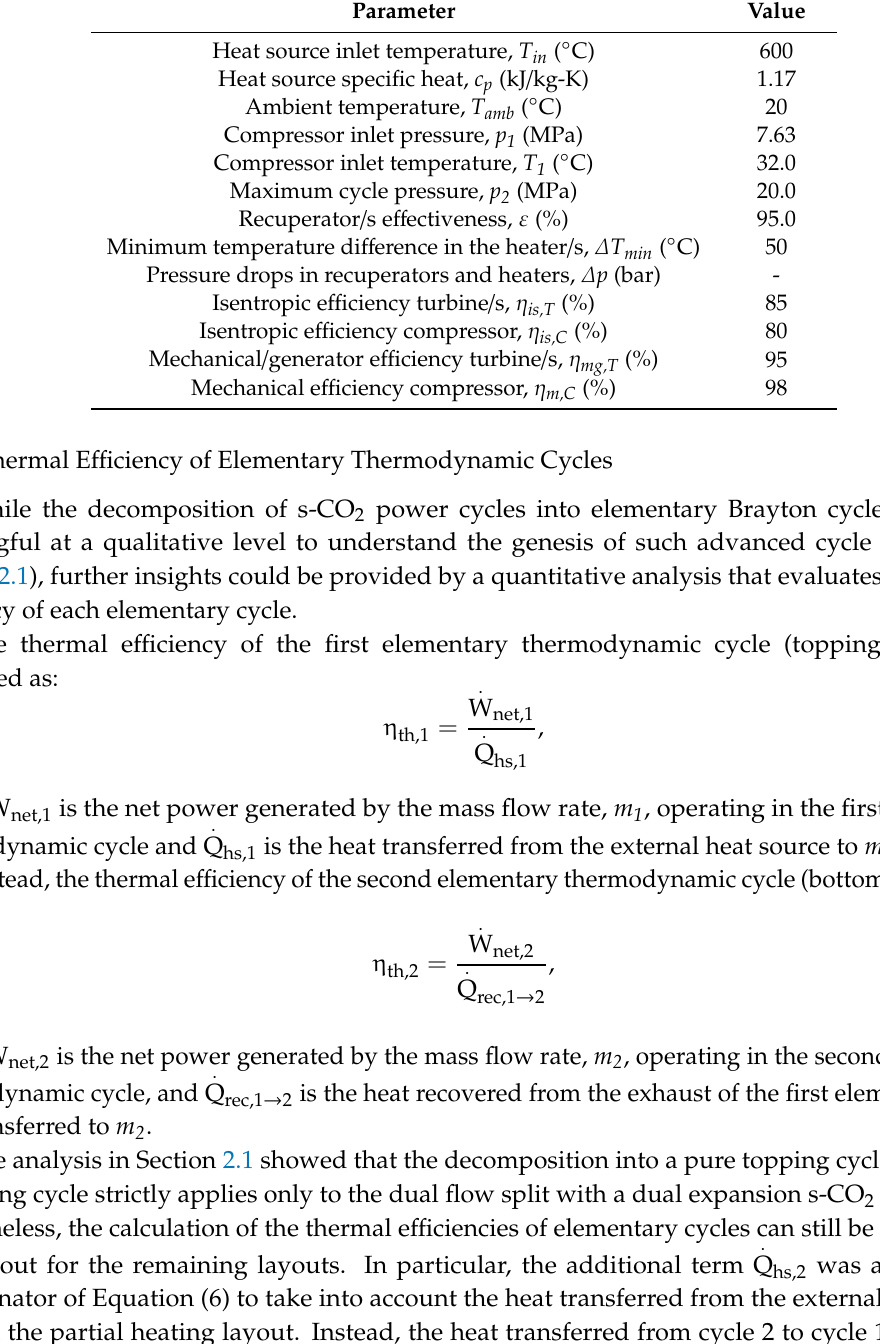
Table 1. Main assumptions in the simulation models of s-CO 2 cycle layouts. Parameter